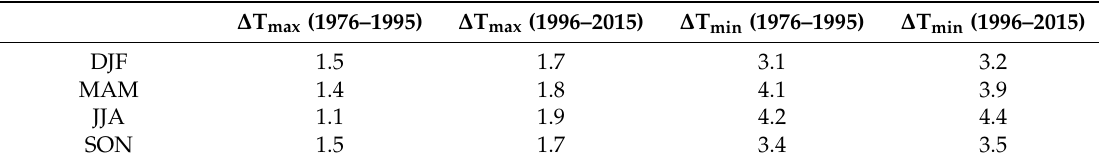
Table 2. Athens seasonally averaged urban heat island (UHI) intensity for T max and T min , calculated from the difference in temperature ( Δ T) between the meteorological stations of NOA (urban) and TAN (rural), for the periods 1976–1995 and 1996–2015. See Figures 2 and 3 for the seasonally averaged maximum and minimum temperatures of the two reference periods.